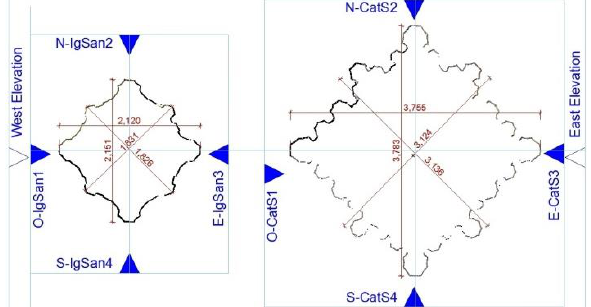
Figure 10. +1.20 m sections of the pillars: the Church of Santiago (left) and the Cathedral of Seville (right)